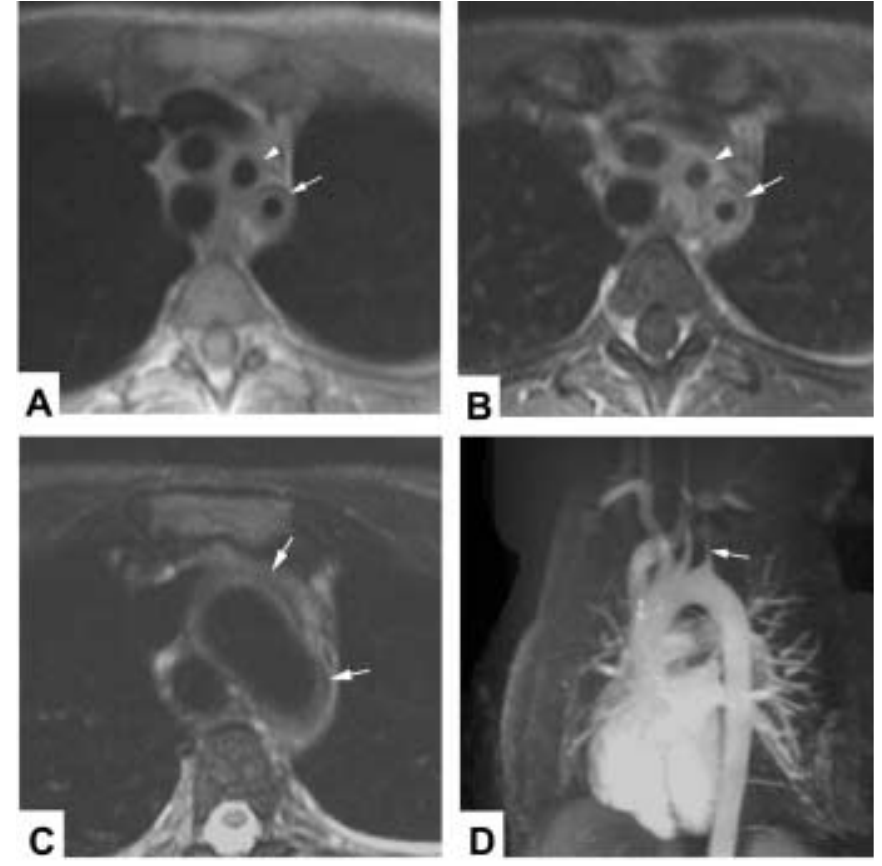
Axial T 1 -weighted MR images before (A) and after intravenous administration of gadolinium chelate (B): luminal changes of the left subcla- vian (arrow) and the left common carotid artery (arrowhead) with wall thickening and contrast enhancement. Axial T 2 -weighted MR images at the level of the aortic arch: hyper-intense wall thickening (C). Sagittal multiplanar intensity projection of the three-dimensional MR angio- graphy: extent of the luminal stenosis of the proximal left subclavian artery